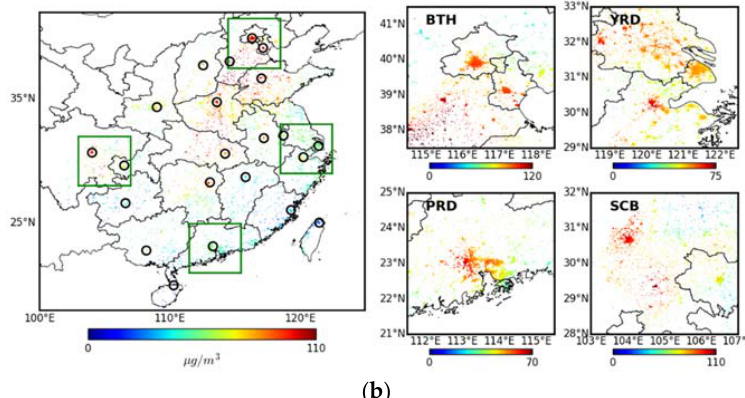
Figure 3. Spatial distributions of the 15 ‐ year means of PM 2.5 concentrations in ( a ) rural and ( b ) urban areas in the study region and four major city clusters (BTH (Beijing ‐ Tianjin ‐ Hebei), YRD (Yangtze River Delta), PRD (Pearl River Delta), and SCB (Sichuan Basin) regions). The locations of the capital cities of the provinces are marked by circles.